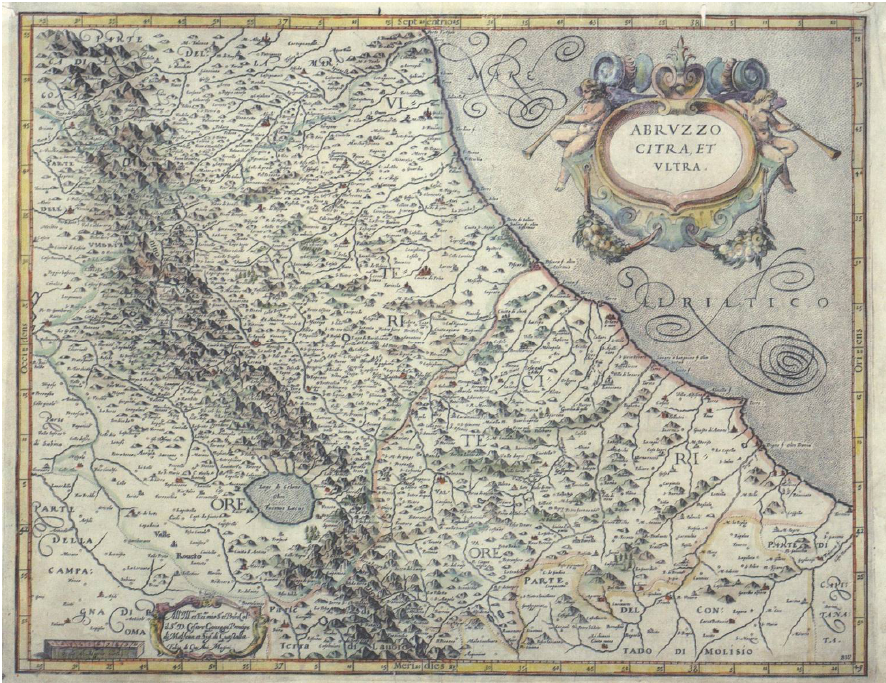
Figure 10. Giovanni Antonio Magini, Abruzzo Ultra et Citra, Bologna (1620), 470 × 372 mm, paper, Archives Collection of Pescara State (R. C. 2753).